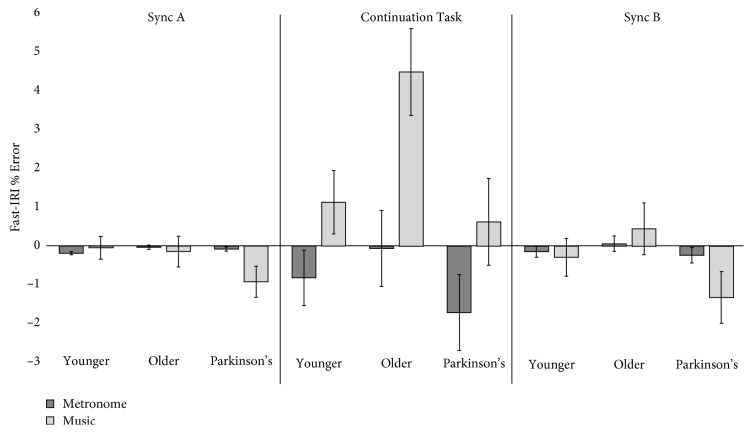
The significant main effect of cue type on entrainment ability (IRI % Error) and the significant interaction between groups in the fast tempo. Y-axis shows IRI % Error. X-axis shows the temporal nature of the experimental paradigm.